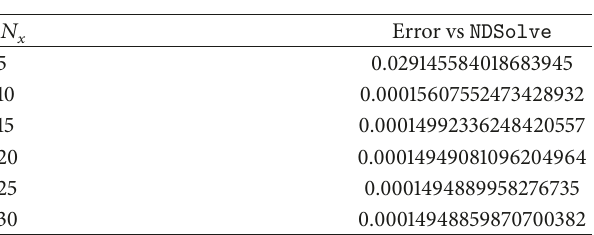
Table 1: Maximum absolute error in the presented method’s solution of the problem described by Example 1 at time 𝑡 = 0.5